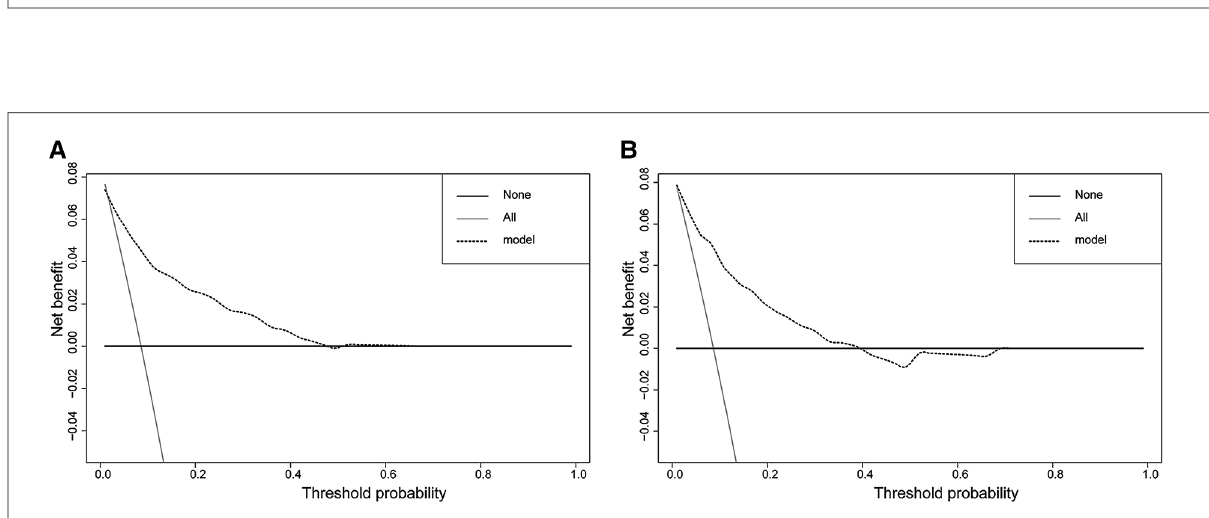
FIGURE 4 Calibration plot of the nomogram. ( A ) The training cohort; ( B ) the validation cohort. The solid gray line shows that the actual DM probability is equal to the predicted probability. With the solid black line almost coinciding with the solid gray line, the plot reveals excellent calibration in both the training cohort and validation cohort.